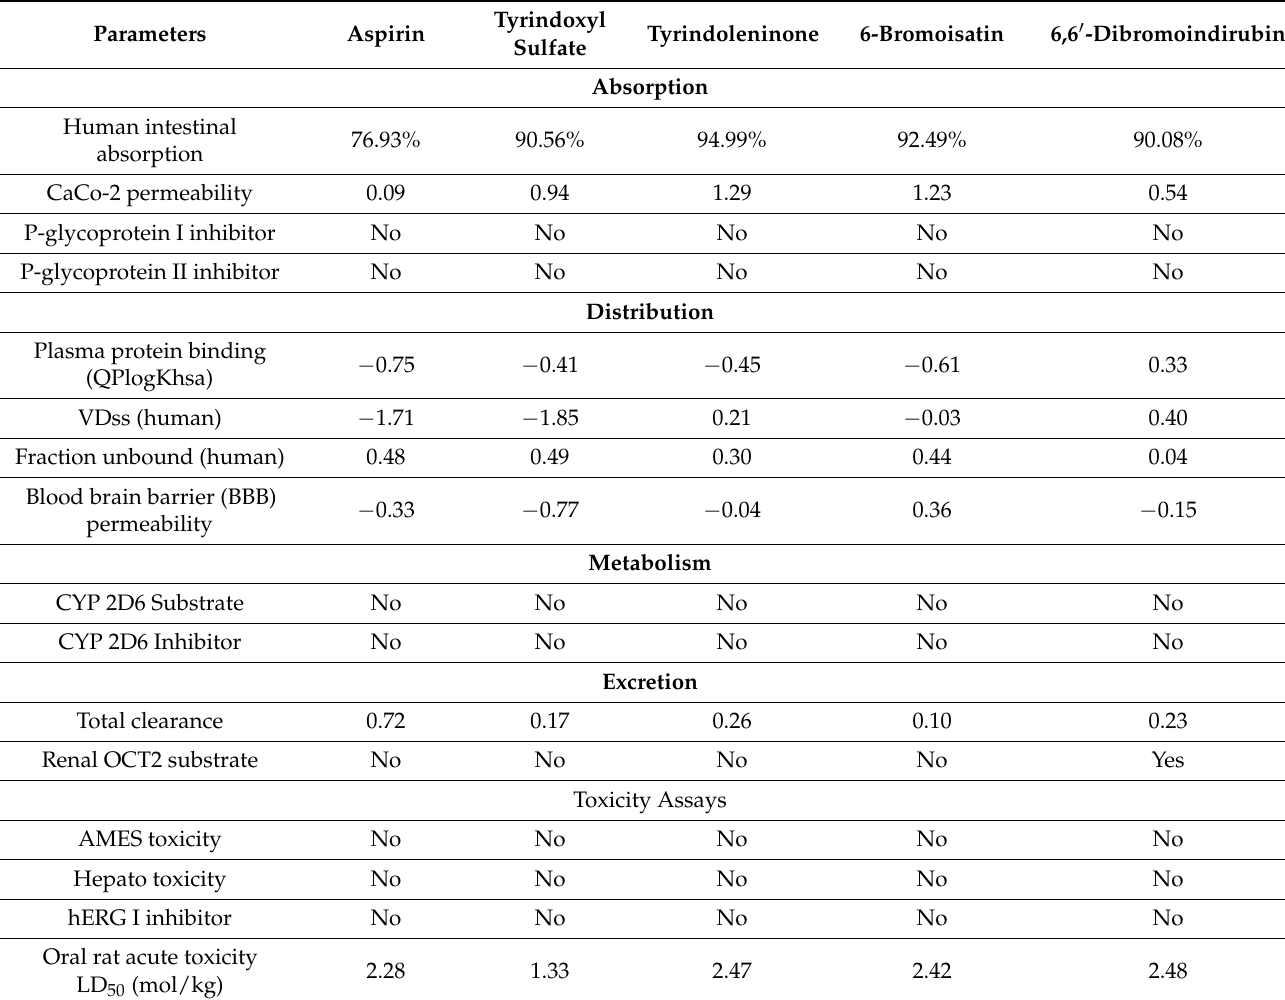
Table 4. Pharmacokinetic and toxicokinetic (ADMET) properties predicted the profile of secondary metabolites of Dicathais orbita compounds compared to the reference molecule by Qikprop and pkCSM. Parameters Aspirin Sulfate